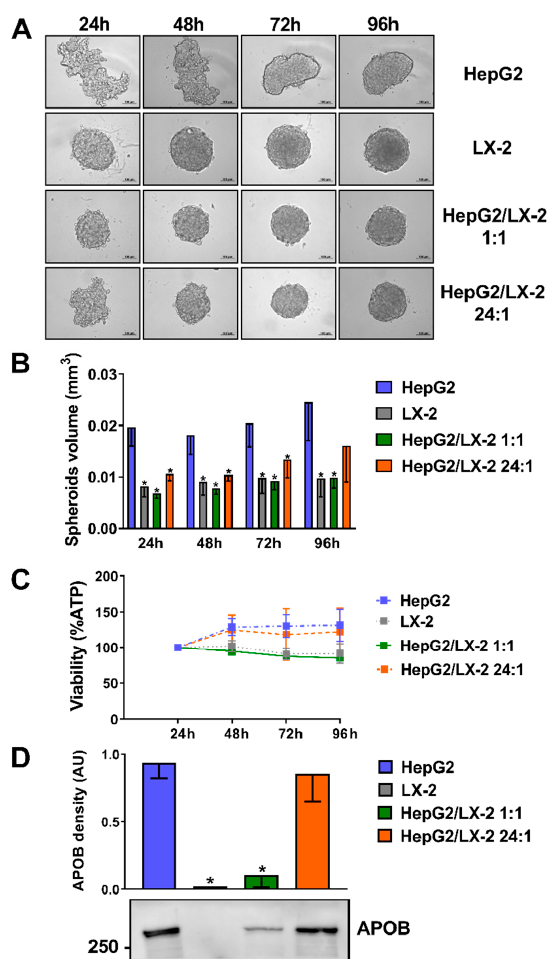
Figure 1. Co-culture of HepG2 and LX-2 cells enhances the compactness of 3D spheroids. ( A ) HepG2 cells, which formed loosely aggregated spheroids alone, were co-cultured as multilineage spheroids with LX-2 cells (forming round-shape spheroids quickly) at a 1:1 and 24:1 ratio for 24, 48, 72 and 96 h. Scale bars in bright-field pictures are 100 μ m. ( B ) Spheroid volume was calculated measuring their long and short diameter by ZEN 2.3 Lite software (Zeiss) ( n = 4). ( C ) Cellular ATP levels normalized to spheroids volumes remained stable throughout 4 days of culture ( n = 3). ( D ) Apolipoprotein B (APOB) secretion levels in the media fractions measured by Western blotting are proportioned to the percentage of hepatocytes present in the spheroids ( n = 5). Bars represent mean ± SD. P-values were calculated by Mann-Whitney non-parametric test, (* p < 0.05 vs. HepG2). APOB: Apolipoprotein B; AU: arbitrary